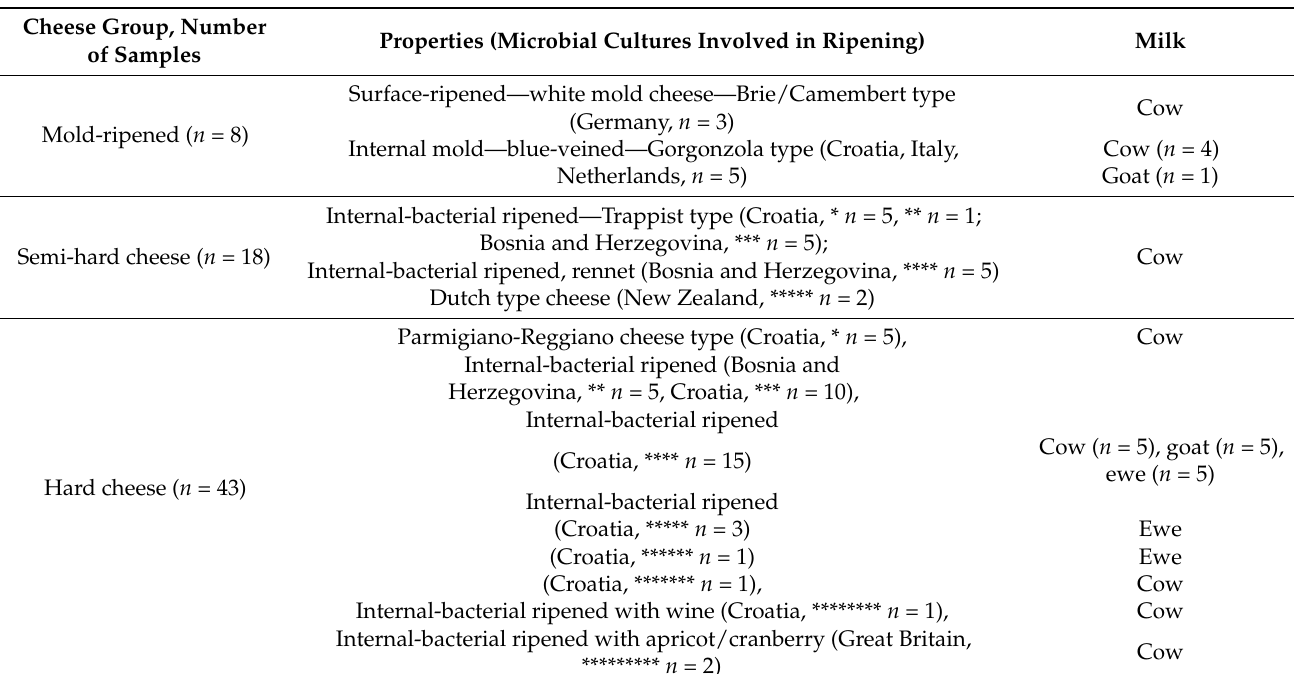
Table 1. Characteristics of retail cheese selected in this